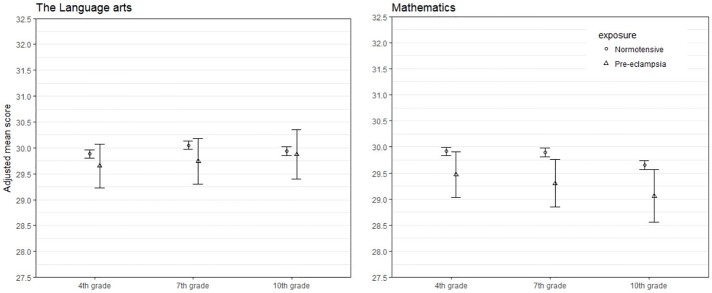
Marginal predicted scoresa in language arts and mathematics by exposure to preeclampsia/eclampsia.